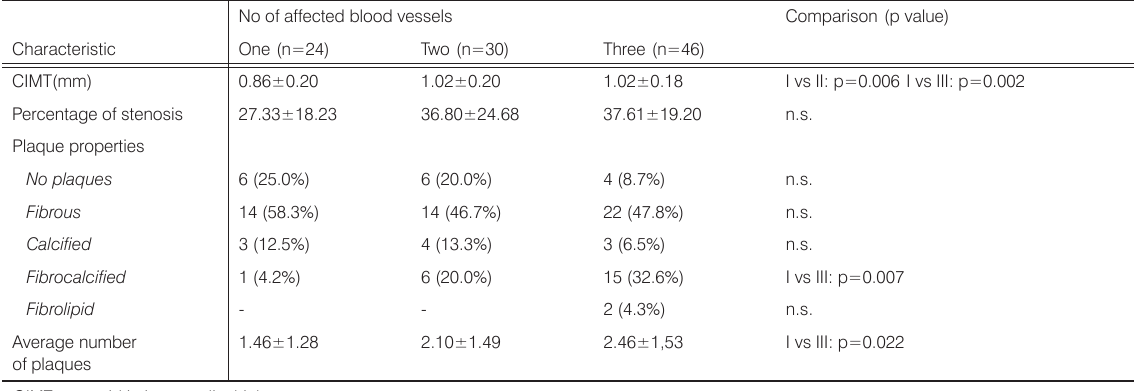
Table 1. Comparison of Doppler characteristics in the carotids of the affected related to the numberof affected coronary blood vesels No of affected blood